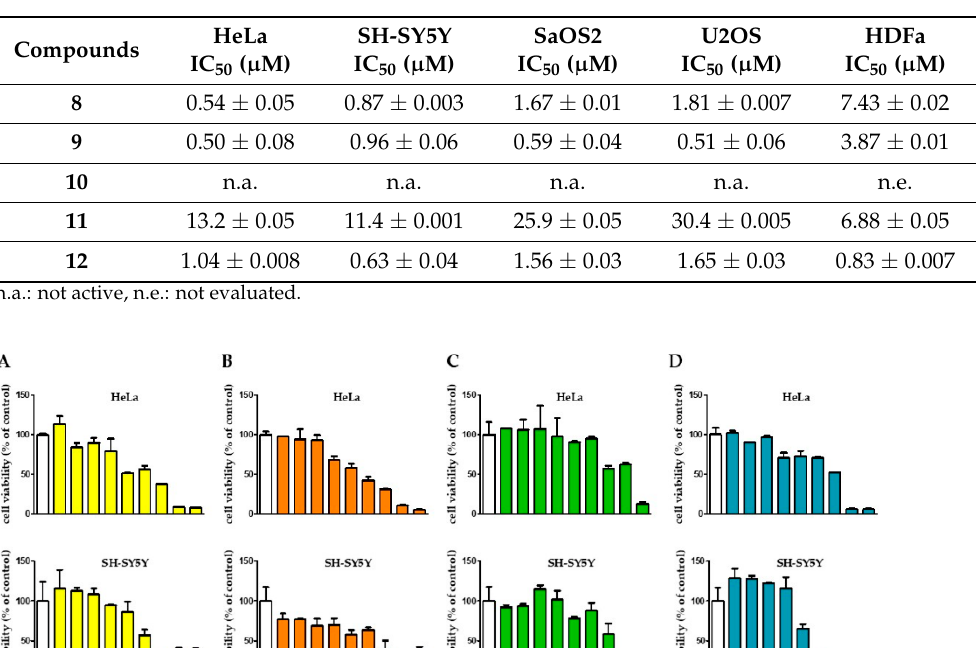
Table 2. Effects of compounds 8–12 on the viability of human cancer and normal cell lines (IC 50 ( µ M) ± SD).